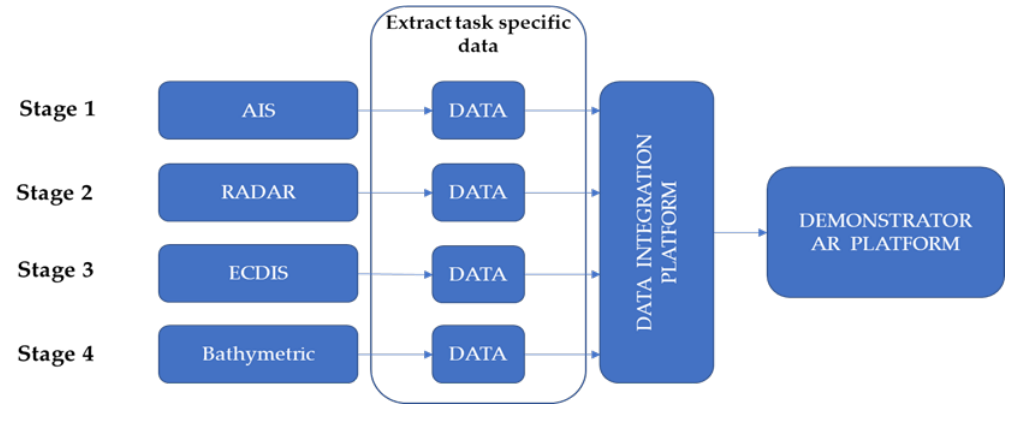
Figure 11. Overall design process.